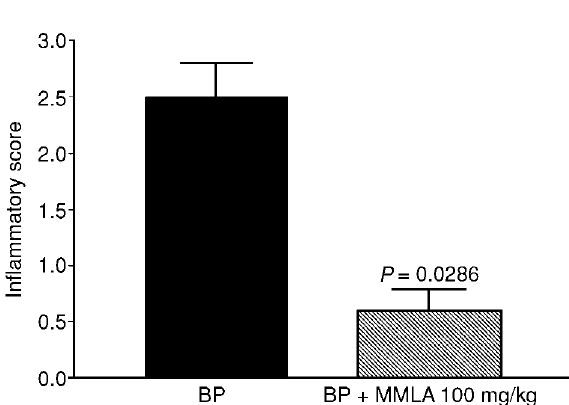
FIG. 1. Mean inflammatory score of mice infected intra- nasally with B. pertussis , and treated with MMLA (100mg/kg i.p. in a single dose). Mice were sacrificed 10 days after infection.